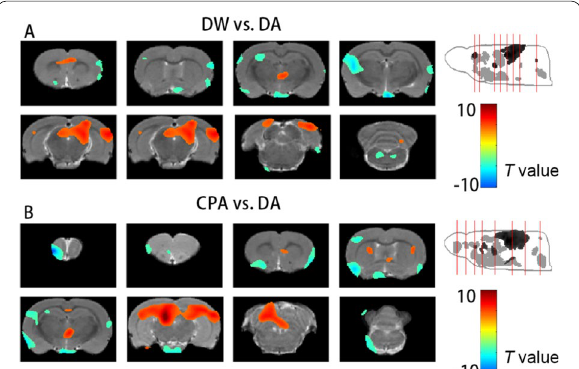
Fig. 4 The result of the changed 18 F-GE180 uptake after drug withdrawal and CPA formation. A The changed 18 F-GE180 uptake in the DW group compared with the DA group. B The changed 18 F-GE180 uptake in the CPA group compared with the DA group. The increased uptake regions are shown in red, while the decreased uptake regions are shown in blue. The red lines on the maximum intensity projection (MIP) image refer to the location of the cross section images on the left, and the cross section images are arranged from front to back, left is left. The color bar represents the T value of each significant